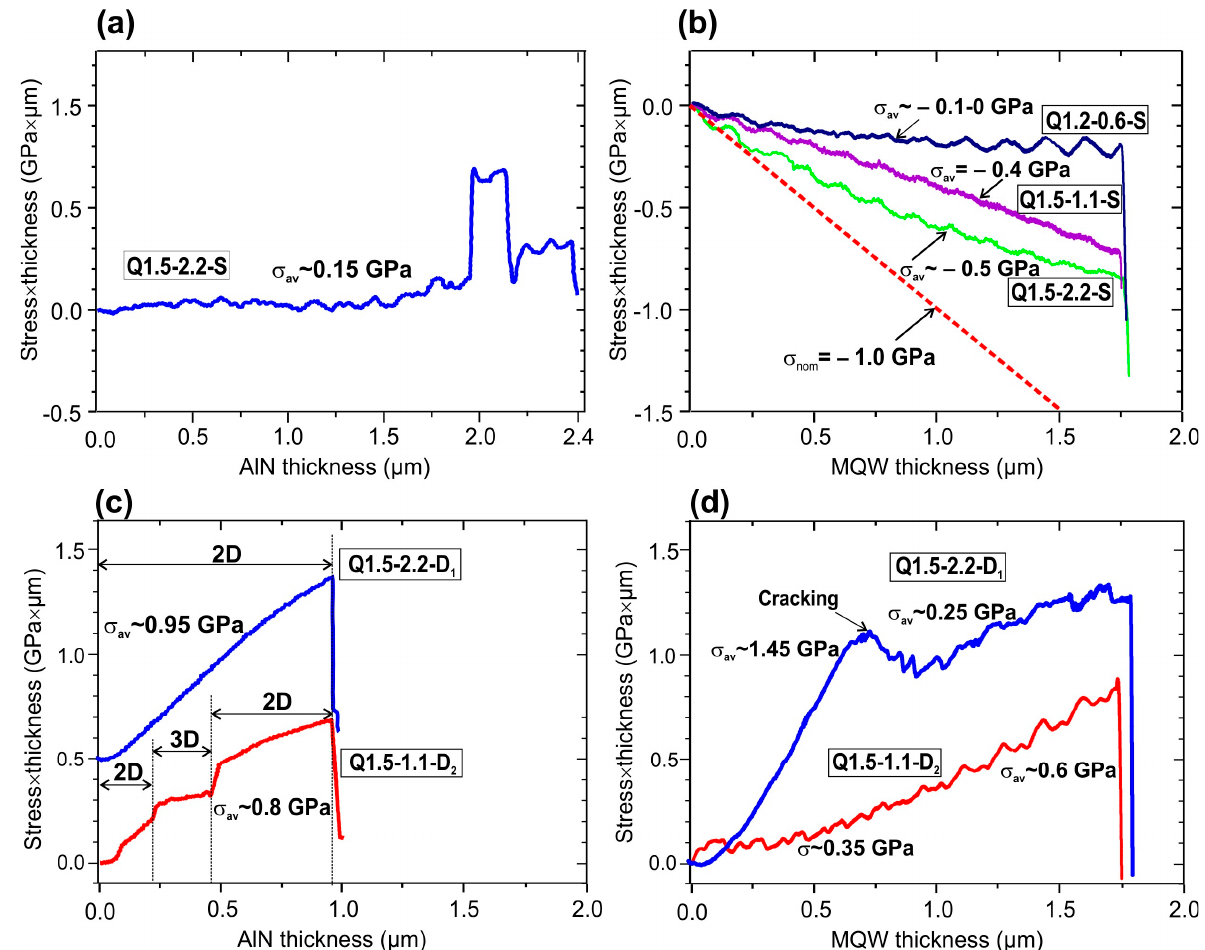
Figure 3. Products (stress × thickness) measured by MOSS during the PA MBE growth of: ( a ) a 2.4 µm-thick S-type AlN/ c -Al 2 O 3 template; ( b ) 400 × {GaN 1.5 /AlN 16 } MQW structures grown on S-type templates under various Ga/N 2 * flux ratios. The dashed, red line corresponds to product’s calculated stress × thickness in a film with a nominal compressive stress of − 0.9 GPa; ( c ) two types of 0.9 µm-thick AlN templates D 1 (blue line) and D 2 (red line) (the former line is shifted upwards for clarity). The thicknesses of parts of the D 2 template grown in 2D- and 3D-growth modes are shown via the lower, red curve; ( d ) 400 × {GaN 1.5 /AlN 16 } MQW structures Q1.5-2.2-D 1 (blue line) and Q1.5-1.1-D 2 (red line). The marked thickness on the blue line in ( d ) corresponds to the occurrence of cracking in this